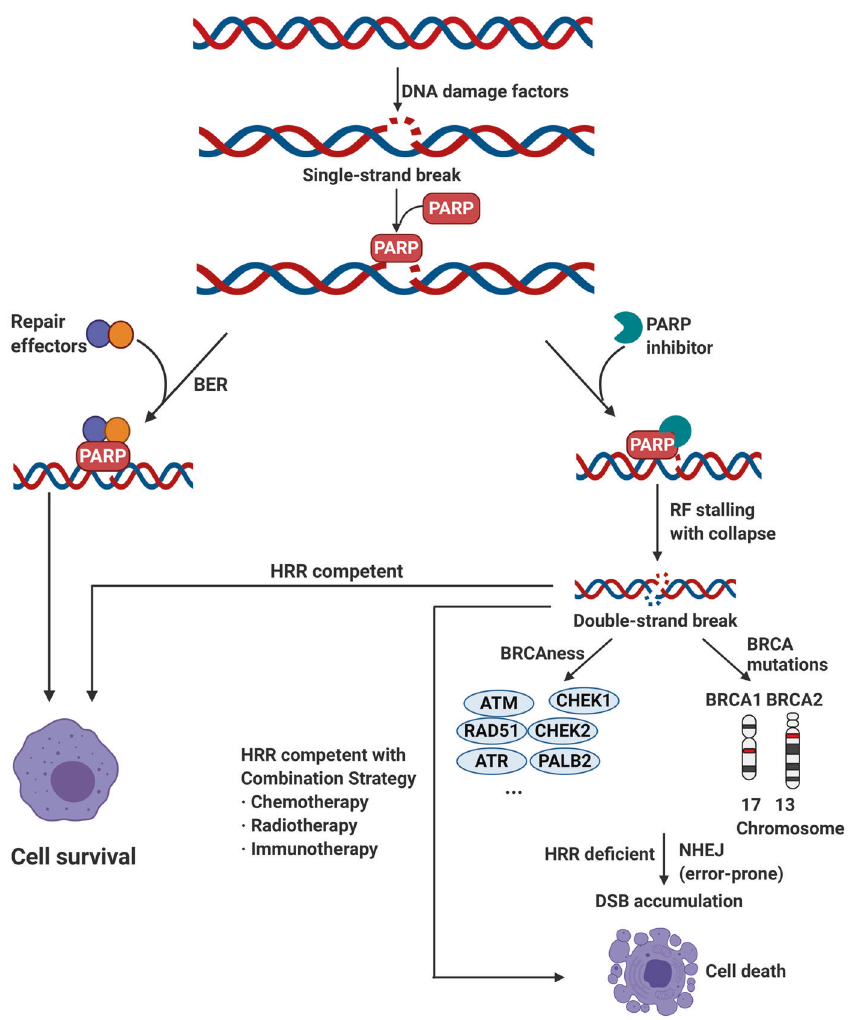
Fig. 7 Molecular process of DNA damage repair related to PARP and the mechanism of action of PARP inhibitors. Endogenous single-strand breaks (SSB) are repaired mostly by PARP-dependent base excision repair (BER) pathway. PARP inhibitors suppress the repair of SSB and the unrepaired SSB can be converted to double-strand breaks (DSB) that are toxic to cells. Homologous recombination (HR) is the major pathway to repair DSB. However, the DSB in BRCA1/2 mutant cells cannot be repaired through HR, thus resulting in genomic instability and cell death. Figure created with